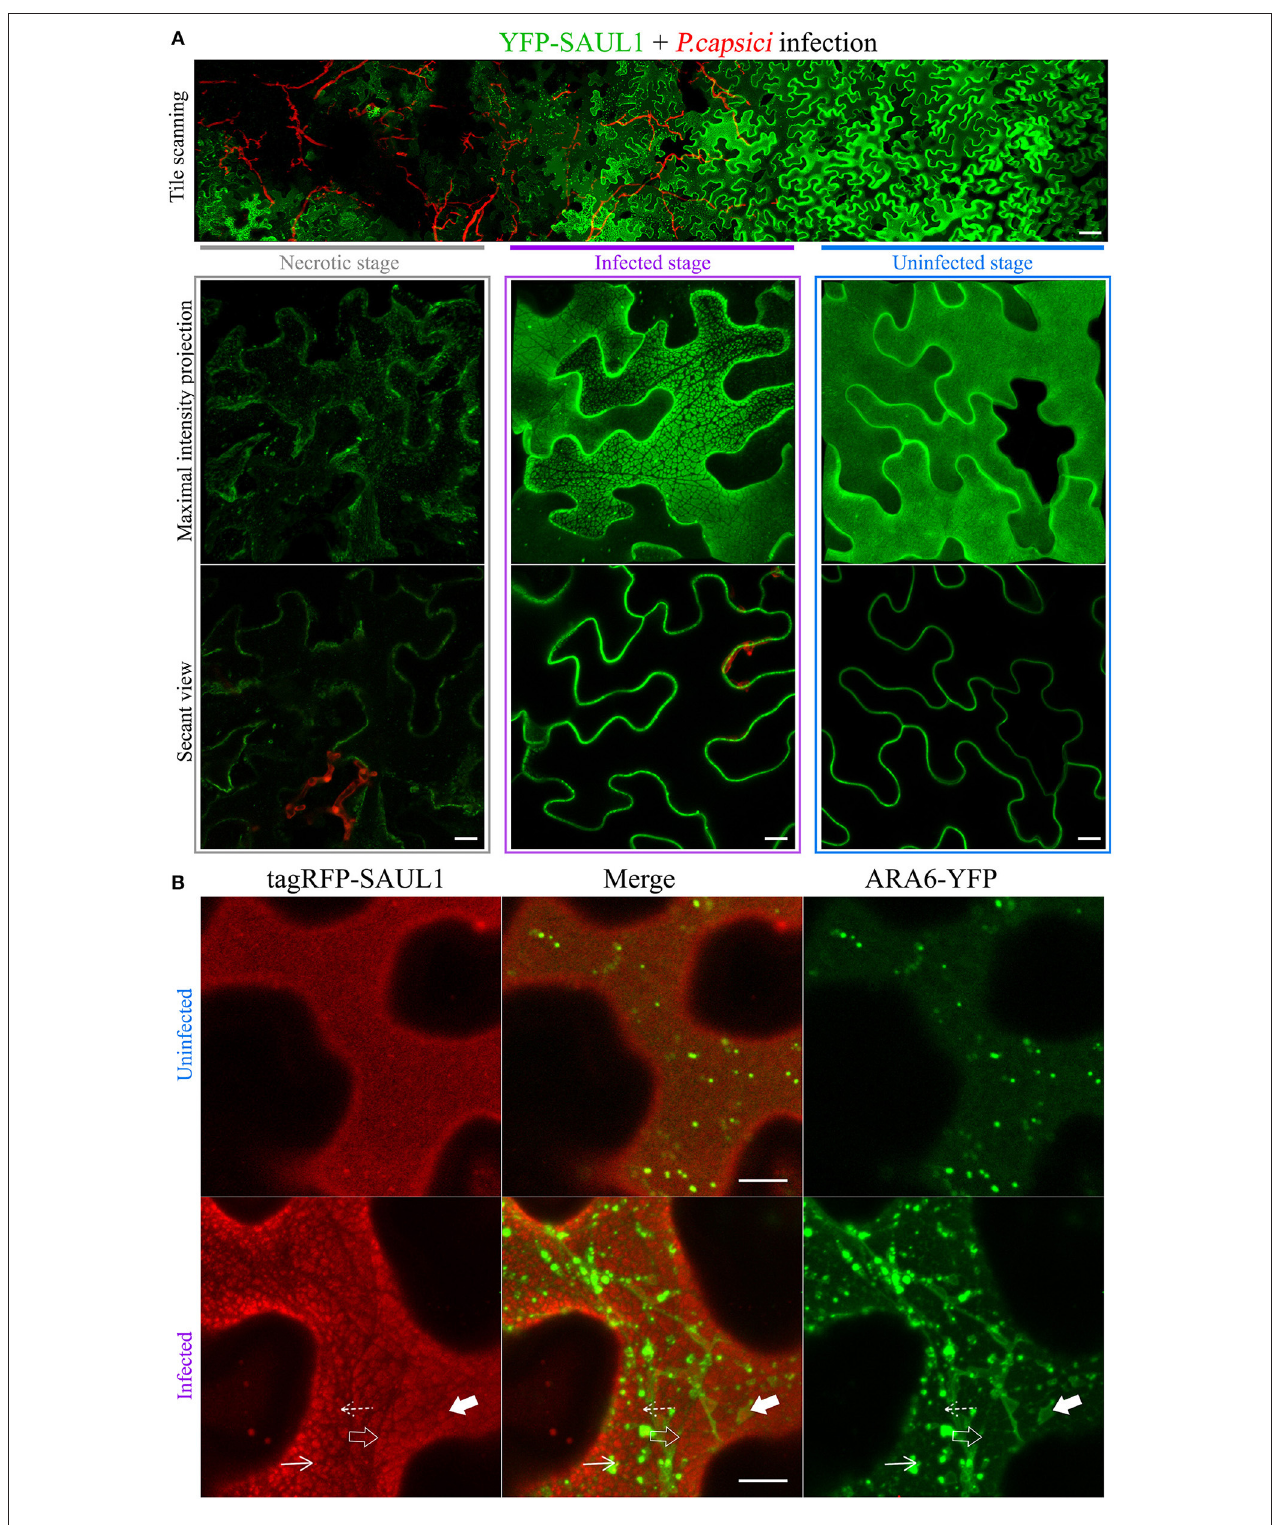
FIGURE 8 | Distribution of the fluorescently tagged full-length SAUL1 in N. benthamiana leaf cortical cells during pathogen infection. (A) Cortical cells expressing YFP-tagged SAUL1 were infected by GFP-tagged oomycete P. capsici (artificially represented by the red color). Top panel: tile-scan imaging showing the changing distribution of YFP-SAUL1 on the PM associated with the progress of P. capsici infection. Scale bar in this panel represents 50 µ m. Lower panel: details of